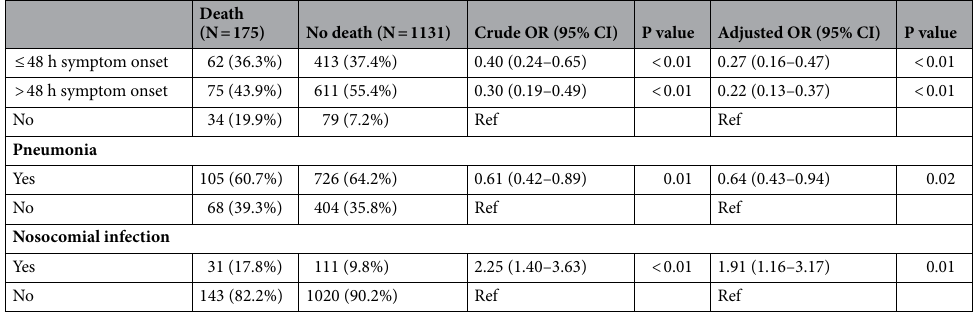
Table 1. Factors associated with death in hospitalized severe influenza patients. COPD: chronic obstructive pulmonary disease, NAI: neuraminidase inhibitors. a Hemoglobinopathy, severe neuromuscular disease or cognitive